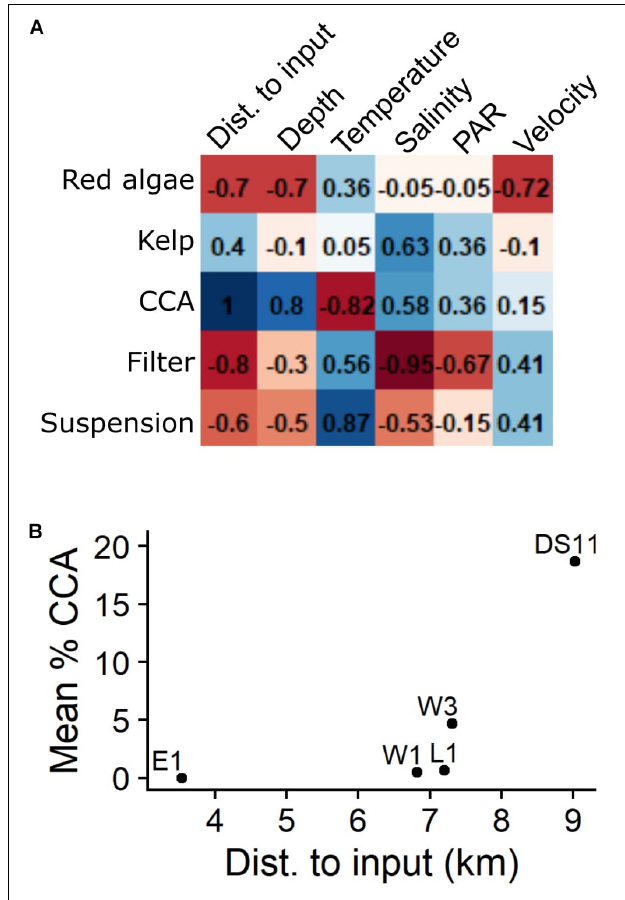
FIGURE 6 | (A) Correlation matrix between percent cover of functional groups and mean environmental variables at each site. Depth and distance to the Sagavanirktok River delta are geographic characteristics, other variables reflect mean May–November conditions ( Table 2 ). Number denotes Spearman rank correlation ( ρ ); ρ = 1 is statistically significant ( p < 0.05). Blue and red color shades depict degree of positive and negative correlation, respectively. (B) Mean percent cover of crustose coralline algae (CCA) in the benthic community at each site compared to distance to nearest river input (see Figure 1